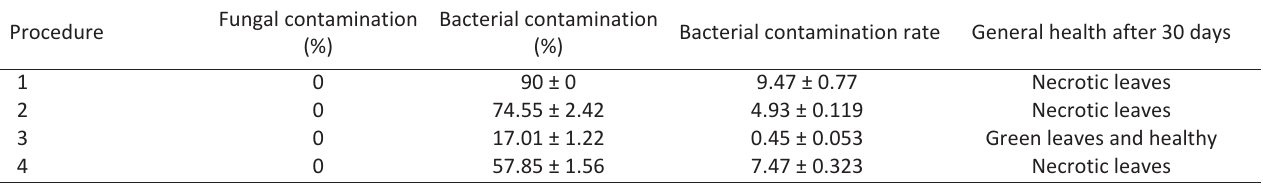
NS = no significant; **= significant at the 0.01 level of probability according to Duncan Test. Table 2 ­ Evaluation of different procedure to come over bacterial contamination during the culture